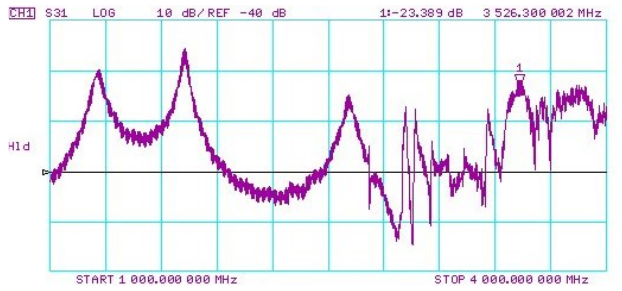
9. (Color) Transmission measurement on the two opposite antennas without beam.